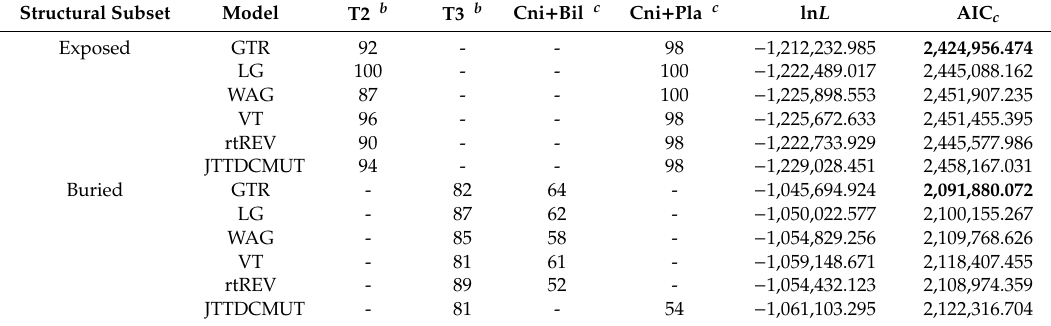
Figure 2. Analyses of sites from different structural environments reveal conflicting phylogenetic signals. We show simplified RaxML trees with both trees are limited to the metazoan ingroups and the choanozoan outgroup (i.e., only Apoikozoa sensu Budd and Jensen [78] are shown). The position of the root drawn in these trees was established by the outgroup taxa (the holozoans Capsaspora and Sphaeroforma and the fungi Saccharomyces and Spizellomyces ). Bootstrap support for the positions of sponges and ctenophores given the general time reversible (GTR) model and the Le and Gascuel [52] (LG )model is indicated next to the arrow. Table 1. Log likelihood and AIC c values a for empirical models and the GTR model optimized for exposed and buried sites. The GTR model had the best fit (note bold AIC c value).